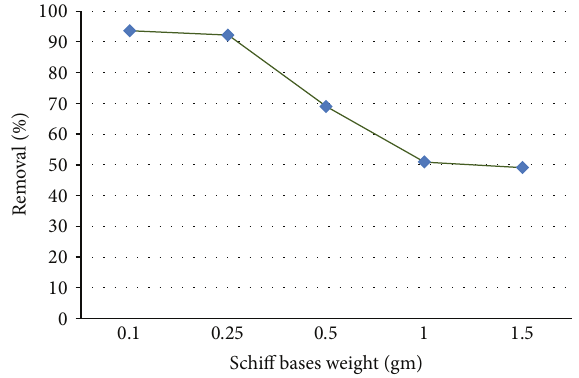
Figure 6: Effect of Schiff bases weight on metal ion